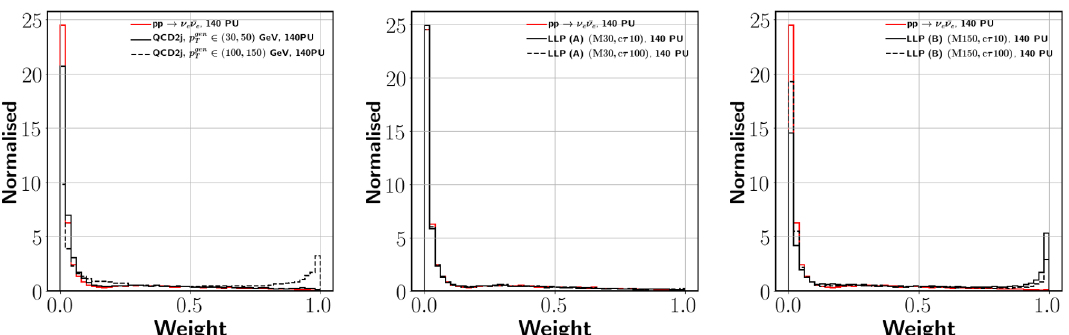
Figure 12 . Distribution of weight of each neutral particle calculated using the procedure followed in ref. [71] for QCD dijet process with p gen ∈ { 30 , 50 } GeV and {100,150} GeV ( top left ), and LLP of T mass 30 GeV from scenario (A) ( top right ) and 150 GeV from scenario (B) ( bottom ) with cτ = 10 cm and 100 cm each, all merged with an average of 140 PU vertices. Distribution for minimum bias events is also shown for comparison in each